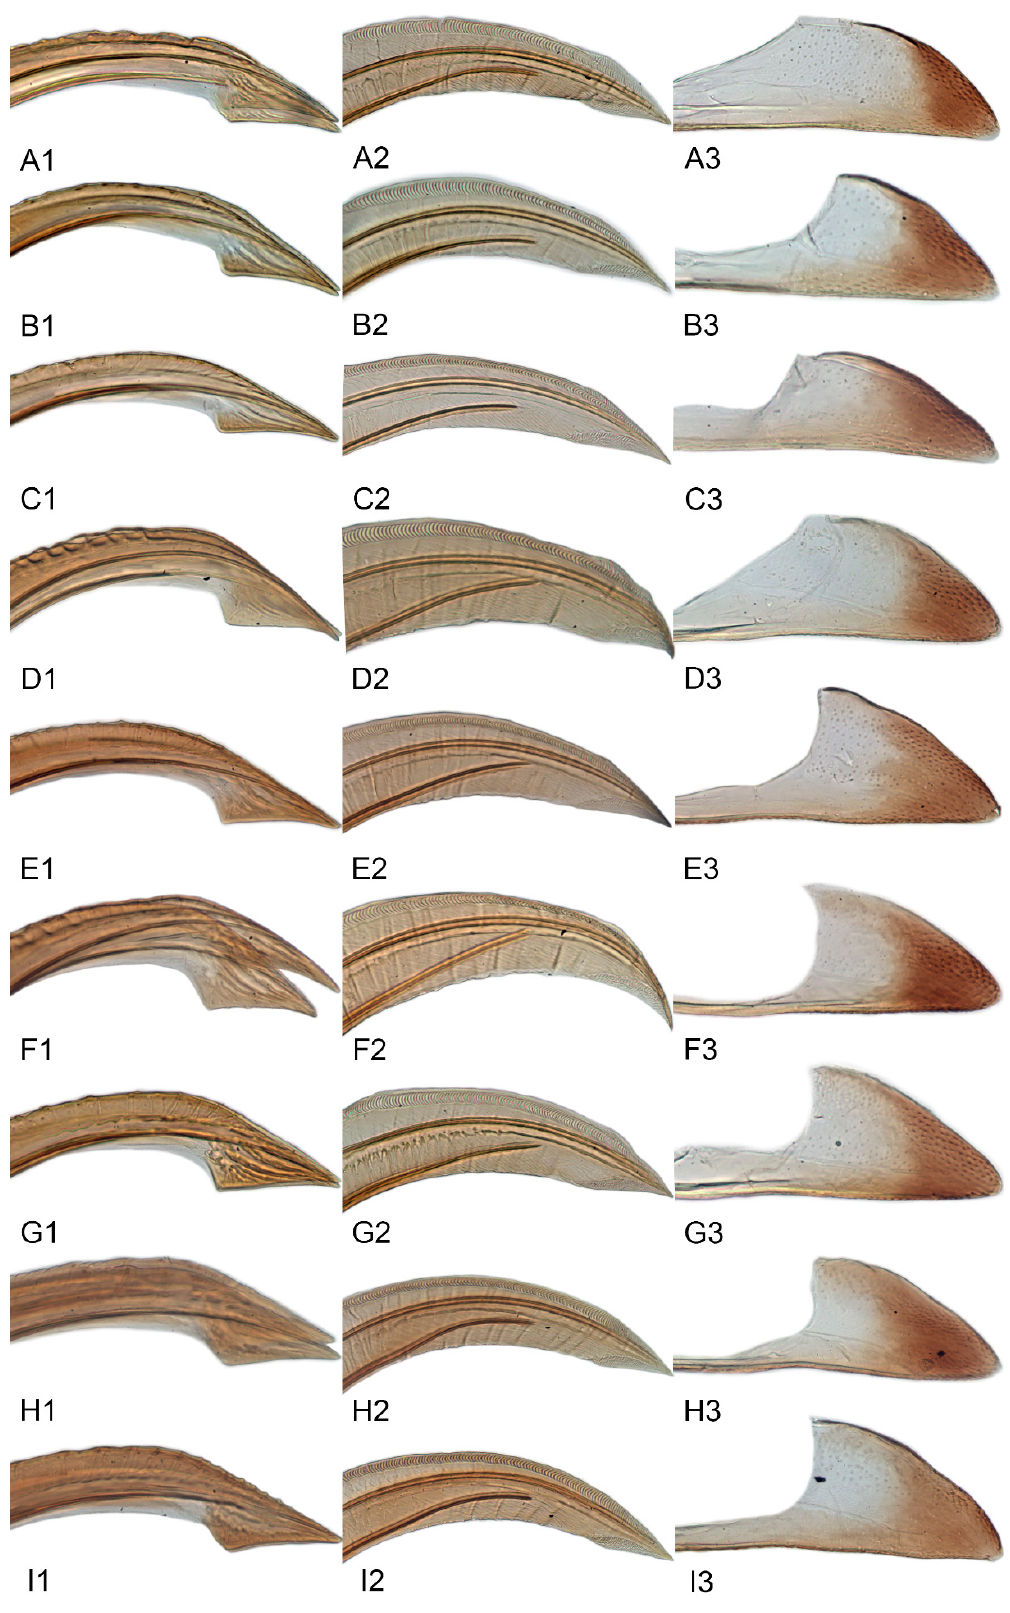
Figure 25. Dissected parts of ovipositor, showing detail of second, first, and third valvulae apex. ( A1 – A3 ) X. asper ; ( B1 – B3 ) X. guttulatus ; ( C1 – C3 ) X. ishidae ; ( D1 – F3 ) X. nonattribus sp. nov.; ( G1 – G3 ) X. binarius sp. nov.; ( H1 – H3 ) X. densprint sp. nov.; ( I1 – I3 ) X. toroensis .